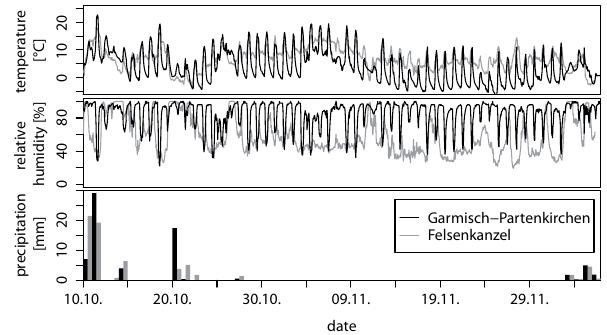
Fig. 3. Meteorological conditions (diurnal course of temperature, relative humidity and daily sum of precipitation) during the excep- tional dry period in autumn 2011 at Garmisch-Partenkirchen (black lines/bars) and Felsenkanzel (grey lines/bars) stations. For fire oc- currence information, refer to Sect. 1.4.